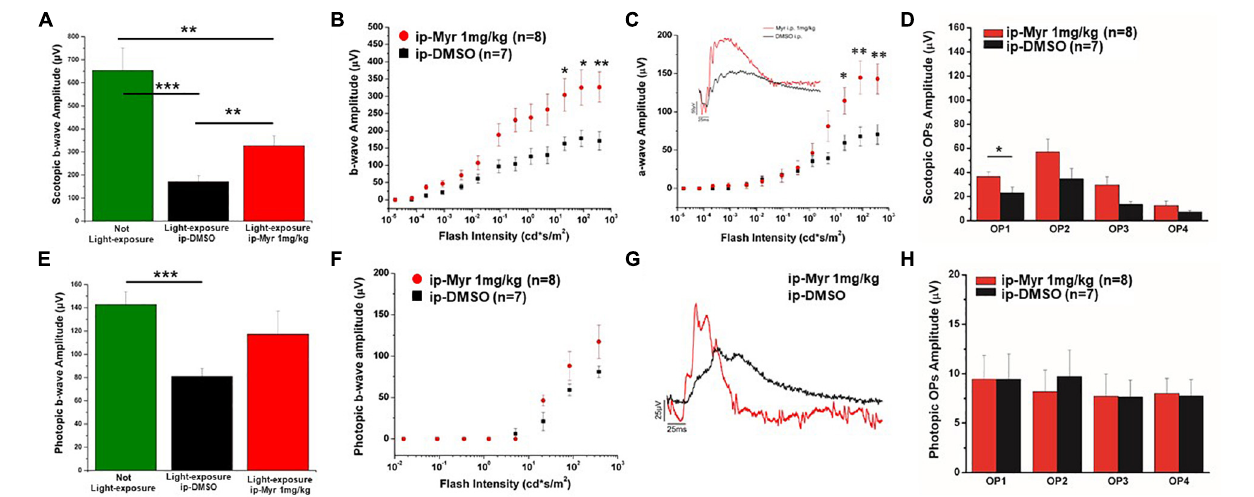
FIGURE 3 | Functional recovery in Tvrm4 mice after Myriocin intraperitoneal (i.p.) treatment. (A) The bar graph shows the scotopic b-wave amplitude measured at the highest luminance in non-induced control animals (green bar), in animals treated, after light induction, with vehicle (black bar), or with Myriocin (red bar). (B) The sensitivity curve of b-wave amplitude as a function of luminance shows a significant increase in Myriocin-treated versus control group. (C) The sensitivity curve of a-wave amplitude as a function of luminance shows a significant increase in Myriocin-treated versus control group. The inset represents an example of ERG traces recorded at the highest luminance used (377 cd*s/m 2 ). (D) Scotopic OPs obtained from ERG traces; the bar graph shows that only the OP1 relative to photoreceptor activity is significantly larger in Myriocin-treated mice with respect to the control mice. (E) Photopic ERG recordings from the not light-exposed Tvrm4 mice (green bar), vehicle-treated (black bar), and Myriocin-treated (red bar) mice. (F) The sensitivity curve of b-wave amplitude as a function of luminance shows a tendency to be larger in the Myriocin-treated group with respect to the control group. (G) Representative example of ERG traces recorded at the highest luminance used (377 cd*s/m 2 ) superimposed on a steady background (30 cd/m 2 ). (H) Photopic OPs obtained from ERG traces. The value represents mean ± SEM; * p ≤ 0.05, ** p ≤ 0.01, *** p ≤